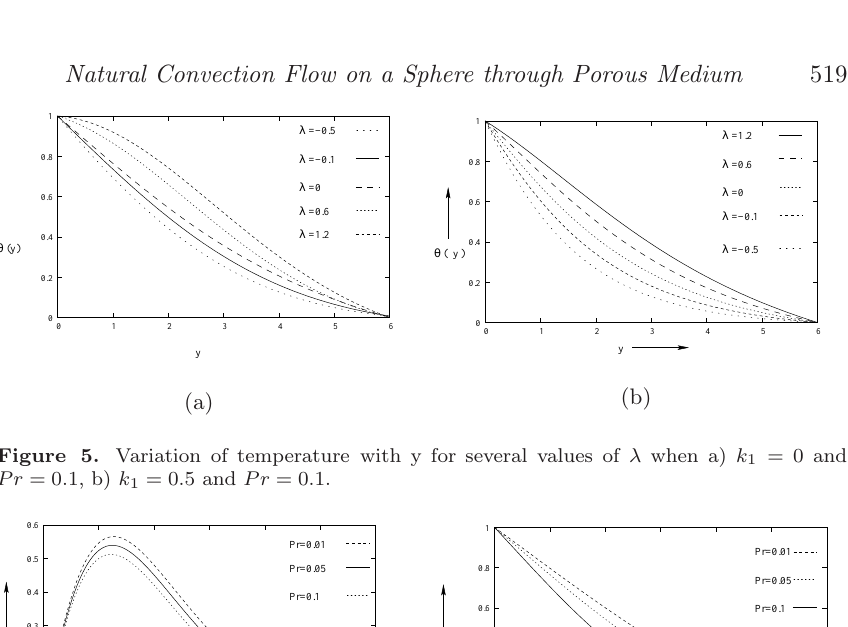
Figure 6. Variation of velocity profiles with y for several values of Pr when a) k 1 = 0 . 5 and λ = 0 .